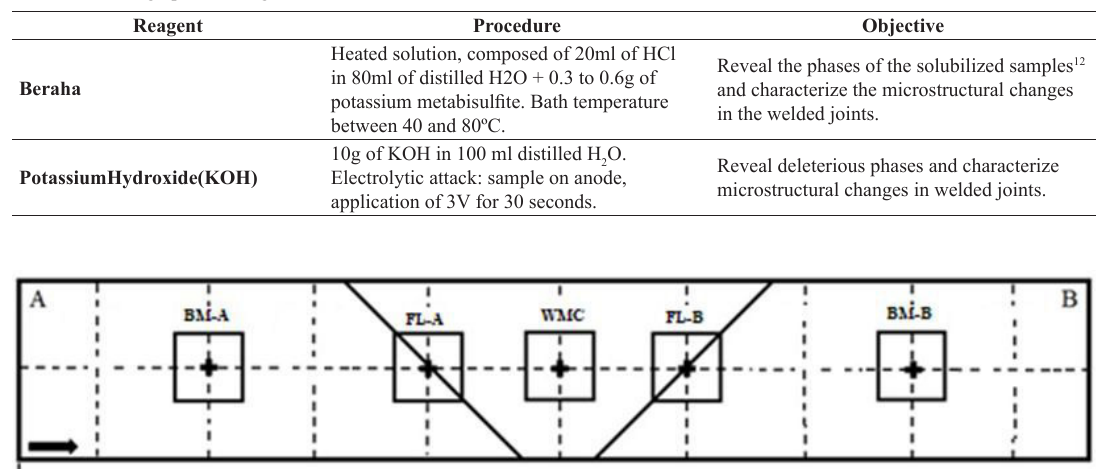
Table 2. Metallographic etchings used to reveal the microstructures.